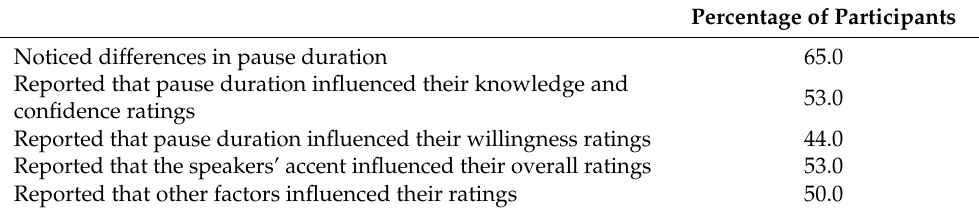
Percentage of Participants